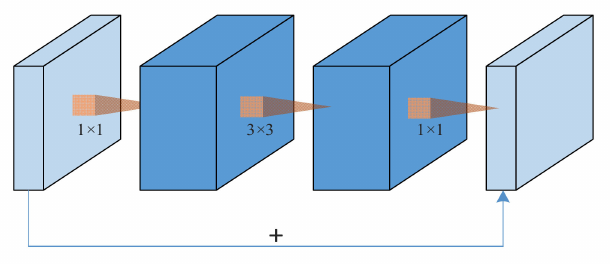
Figure 4. Reverse residual